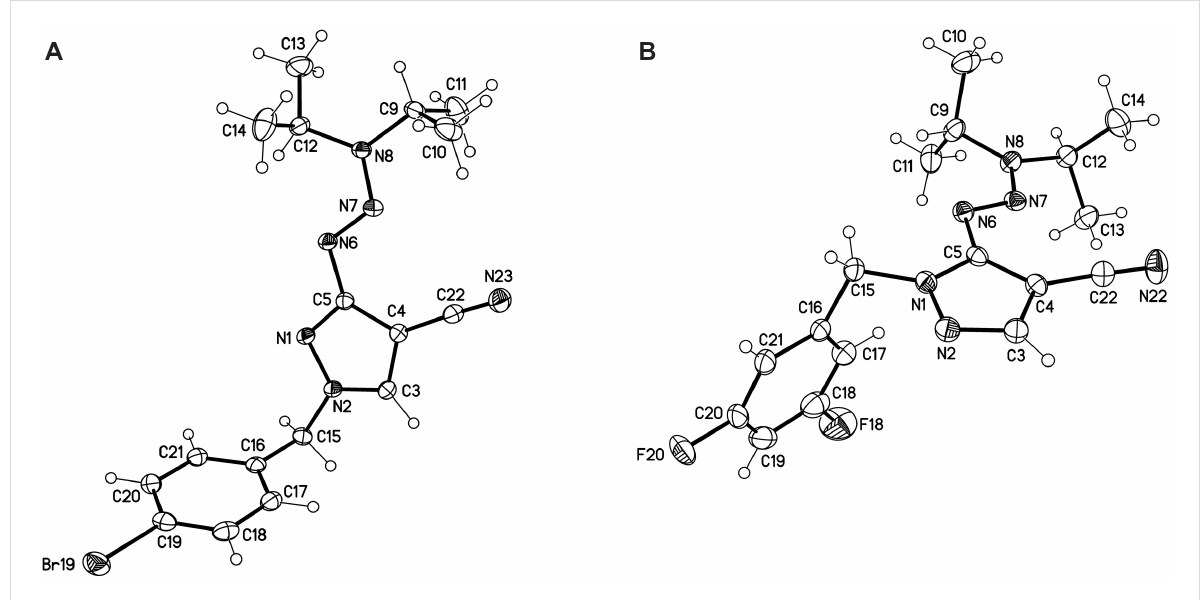
Figure 2: Molecular structures of compounds 12h (A) and 13c (B) representing both possible regioisomers of the alkylation reaction (displacement parameters are drawn at the 50% probability level). The X-ray data corroborate the obtained NMR data.